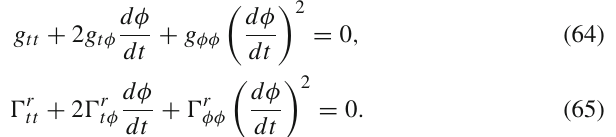
Fig. 7 Shadow of stationary ZV metric for γ = 1 (NUT) and γ = 0 . 5 at different inclination angles α for the observer and for different values of q . It can be seen that in the case γ = 1 the introduction of the ‘quasi- NUT’ parameter does not alter the shape of the shadow, thus showing